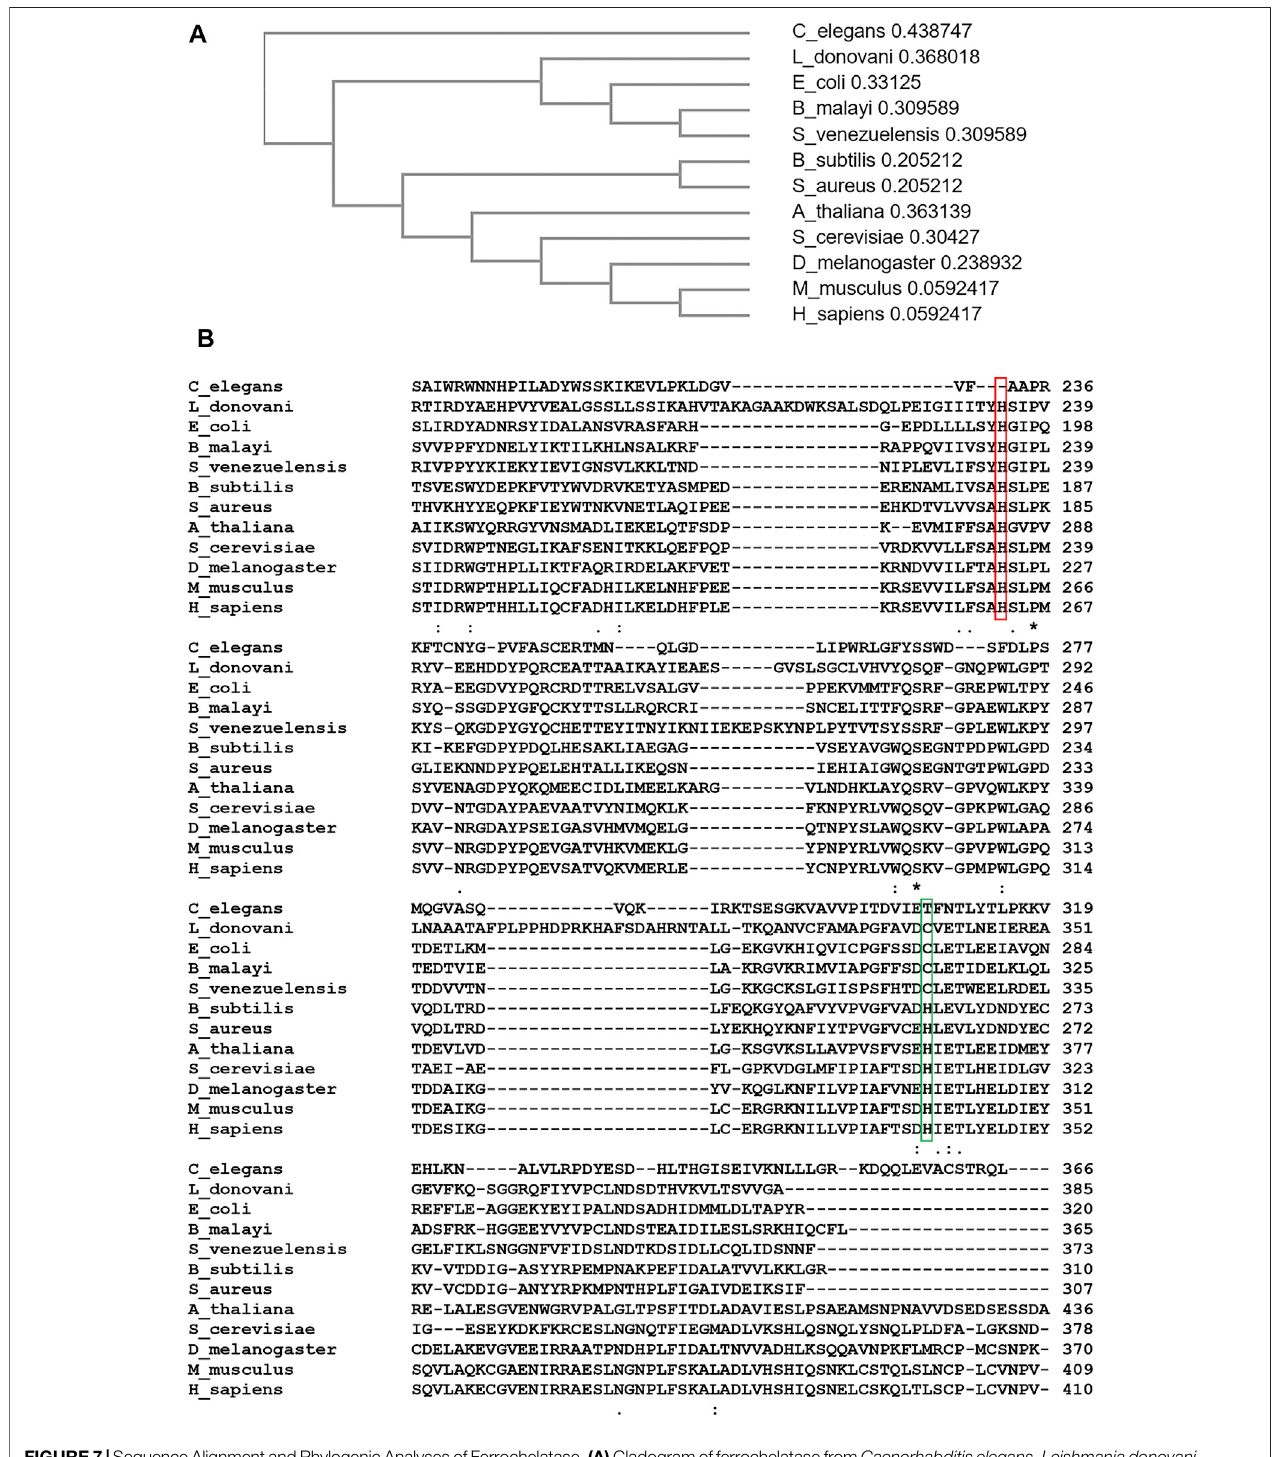
Frontiers in Cell and Developmental Biology |